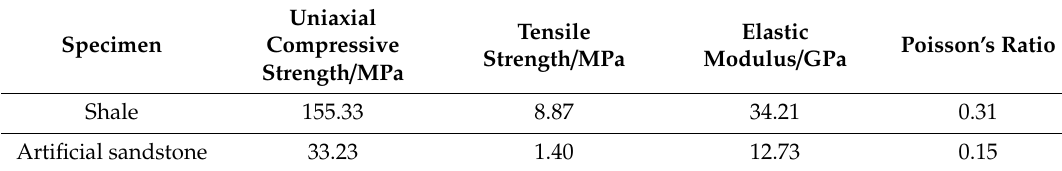
Table 1. Physical and mechanical properties of the